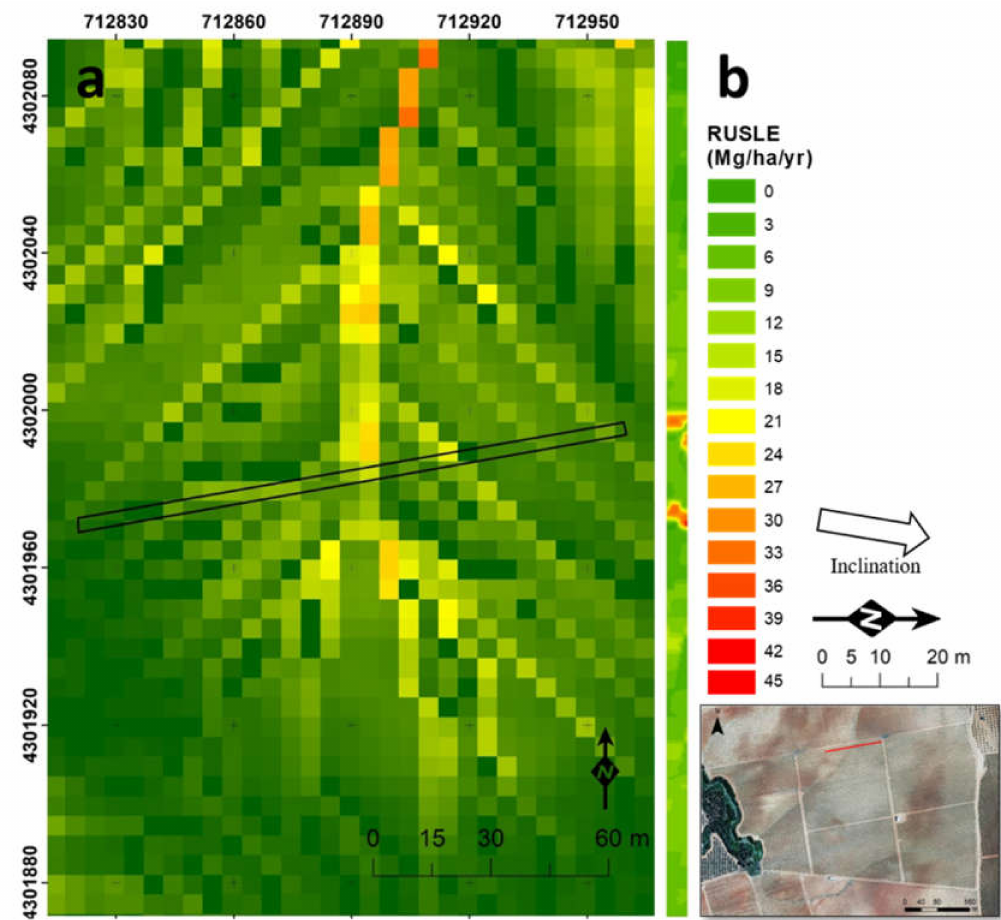
Figure 6. RUSLE (Revised Universal Soil Loss Equation) map of the study site ( a ) and the two vine rows and inter-row ( b ) selected for the study.